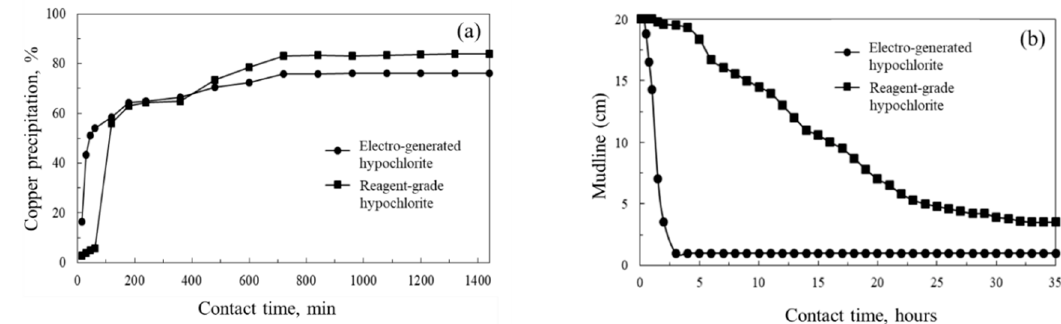
Figure 3. Behavior of copper precipitation used electro-generated NaOCl and reagent-grade NaOCl with contact time ( a ) copper precipitation efficiency, ( b ) mudline change (initial pH, 9.8–11.4; temperature, 298 K; time, 24, 35 h without agitation; total volume, 200 mL with NaOCl/leach solution ratio 1; chlorine concentration 5.2 g/L).